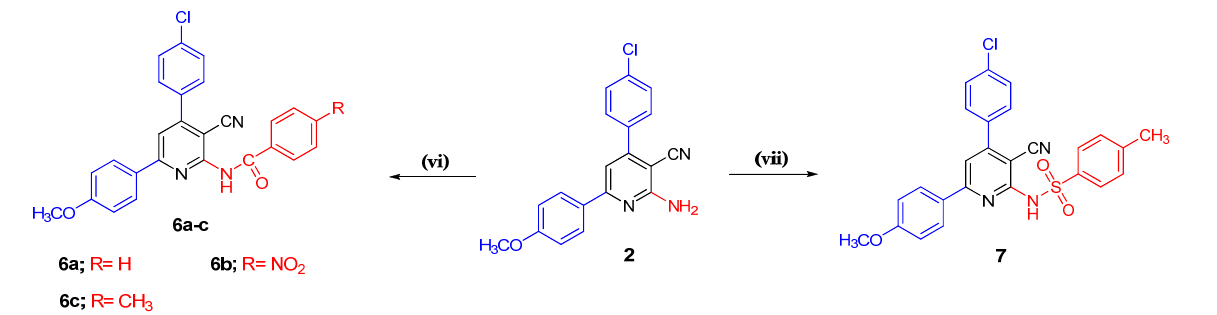
Table 1. Mortality and calculated LC 50 values (mg/mL) noted for active nicotinonitrile derivatives 2 – 7 and Acetamiprid against M. cartusiana land